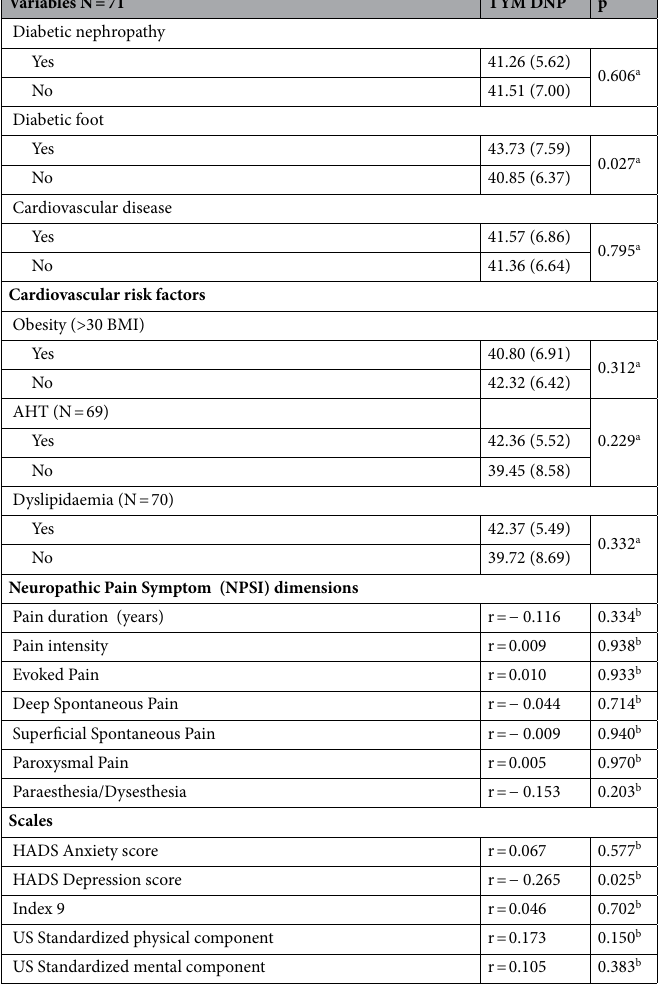
Table 2. Factors related to the cognitive function (global score of Test Your Memory) in DNP patients. Bivariate analysis. Bivariate analysis. a Mann–Whitney. b Spearman Correlation Coefficient. c Kruskal- Wallis. SD = Standard Deviation; BMI = Body Mass Index; AHT = Arterial